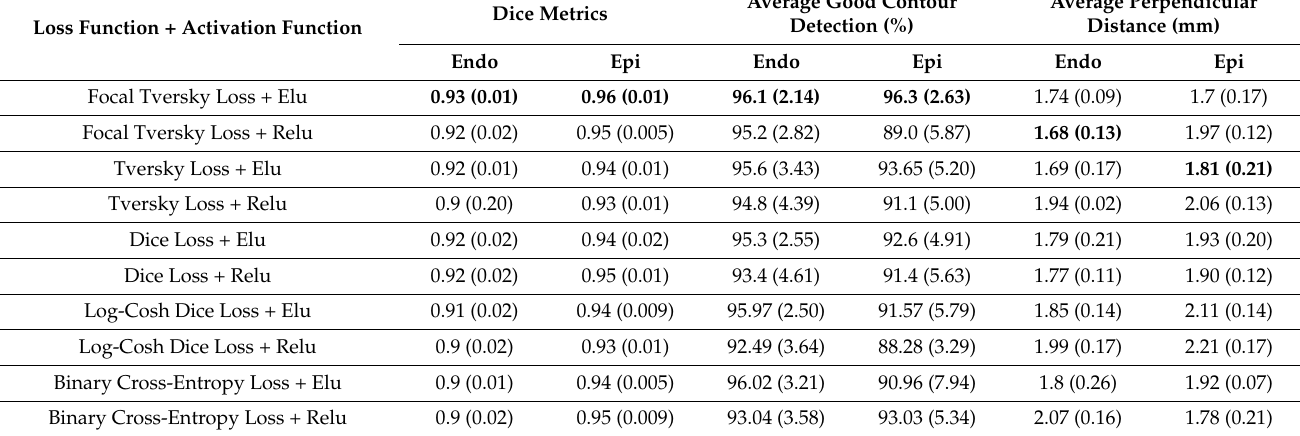
Table 17. Comparison of LV endocardium and epicardium segmentation performance of all models proposed in this research.